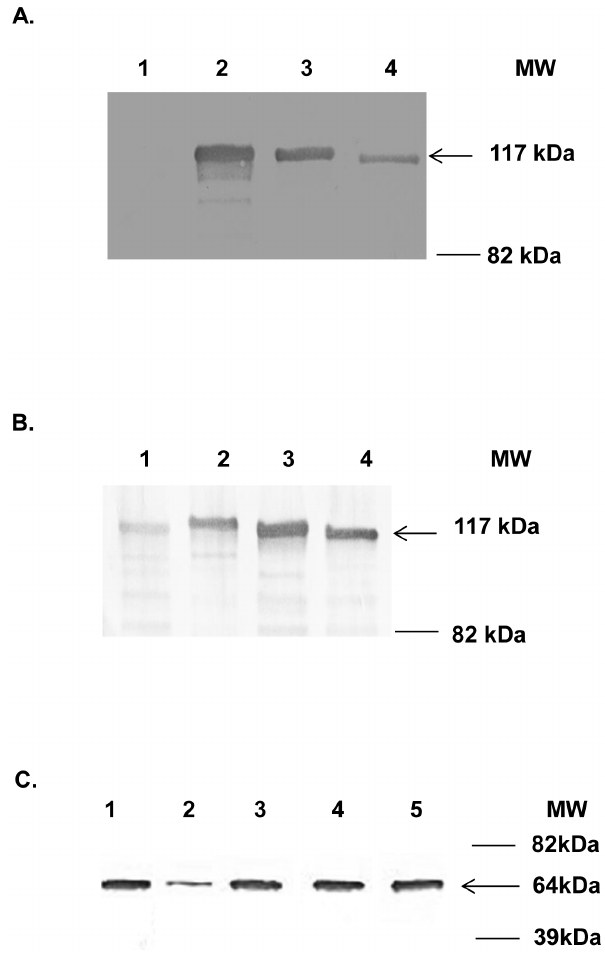
Figure 2. Western blotting confirmed the presence of His 6 , KWAS, and fiber on multivalent vaccine vectors. A) Western blotting confirmed the presence of His 6 incorporation within the dual modified vectors. In this assay, 5 6 10 9 VP of Ad5 (lane 1), Ad/H5-HVR1- His 6 (lane 2), Ad5/H5-HVR1-KWAS-HVR2-His 6 (lane 3), and Ad5/H5- HVR1-KWAS-HVR5-His 6 (lane 4) were separated on 4 to 15% polyacryl- amide gradient SDS-PAGE gel. The proteins were transferred to polyvinylidene fluoride (PVDF) membrane then incubated with anti- His antibody. The arrow indicates the His tag is genetically incorporated into the hexon protein. B) Western blotting confirmed the presence of KWAS incorporation within the dual modified vectors. In this assay, 5 6 10 9 VP of Ad5 (lane 1), Ad5/HVR2-MPER-L15 D E1 (lane 2), Ad5/H5- HVR1-KWAS-HVR2-His 6 (lane 3), and Ad5/H5-HVR1-KWAS-HVR5-His 6 (lane 4) were separated on 4 to 15% polyacrylamide gradient SDS- PAGE gel. The proteins were transferred to PVDF membrane then incubated with anti-KWAS antibody. The arrow indicates the KWAS epitope is genetically incorporated into the hexon protein. C) Western blotting confirmed the presence of fiber incorporation within the dual modified vectors. In this assay, 5 6 10 9 VP of Ad5 (lane 1), Ad5/HVR2- MPER-L15 D E1 (lane 2), Ad/H5-HVR1-His 6 (lane 3), Ad5/H5-HVR1-KWAS- HVR2-His 6 (lane 4), and Ad5/H5-HVR1-KWAS-HVR5-His 6 (lane 5) were separated on 4 to 15% polyacrylamide gradient SDS-PAGE gel. The proteins were transferred to PVDF membrane then incubated with anti- Fiber antibody. The arrow indicates detection of the fiber